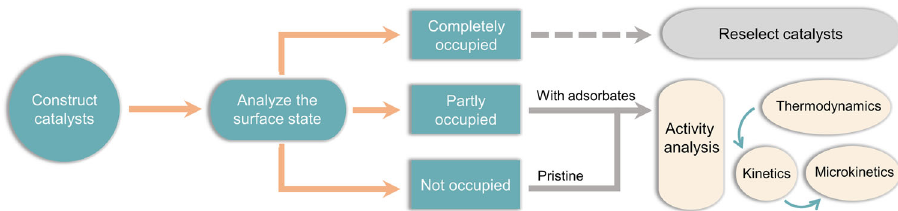
Fig. 6 A recommended DAC design framework for electrocatalysis. A recommended framework for the design and analysis of DACs for electrocatalysis with external gas reactants (e.g., ORR, CO 2 RR, and